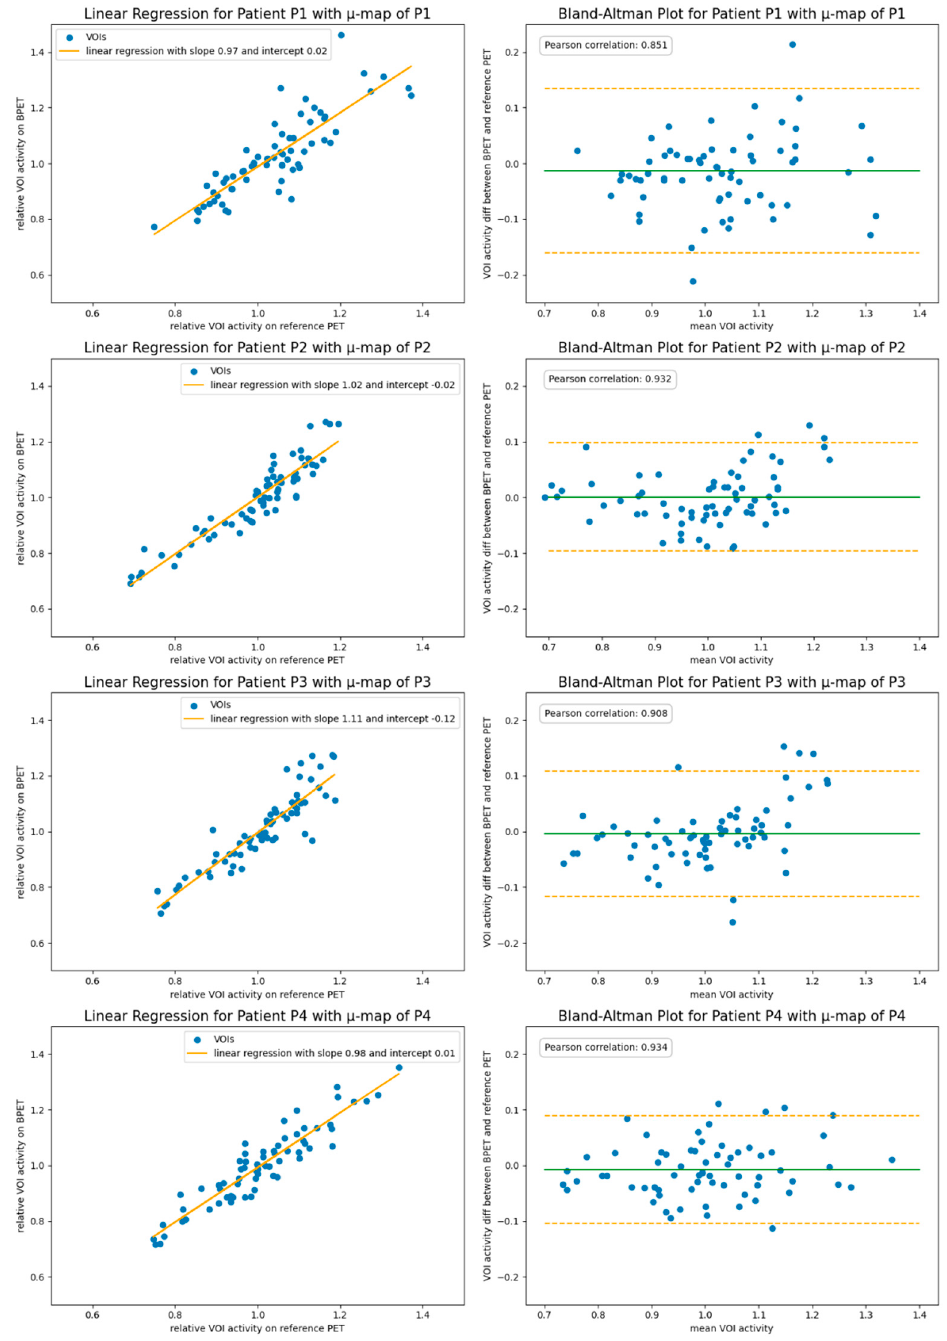
Figure 4. The VOI comparison of reconstructions using the patient-specific reference CT scan for attenuation correction. Shown left are the linear regression plots. Shown in the right column are the Bland–Altman plots indicating the 1.96 SD bars (orange) at either side of the mean intensity ratio (green).